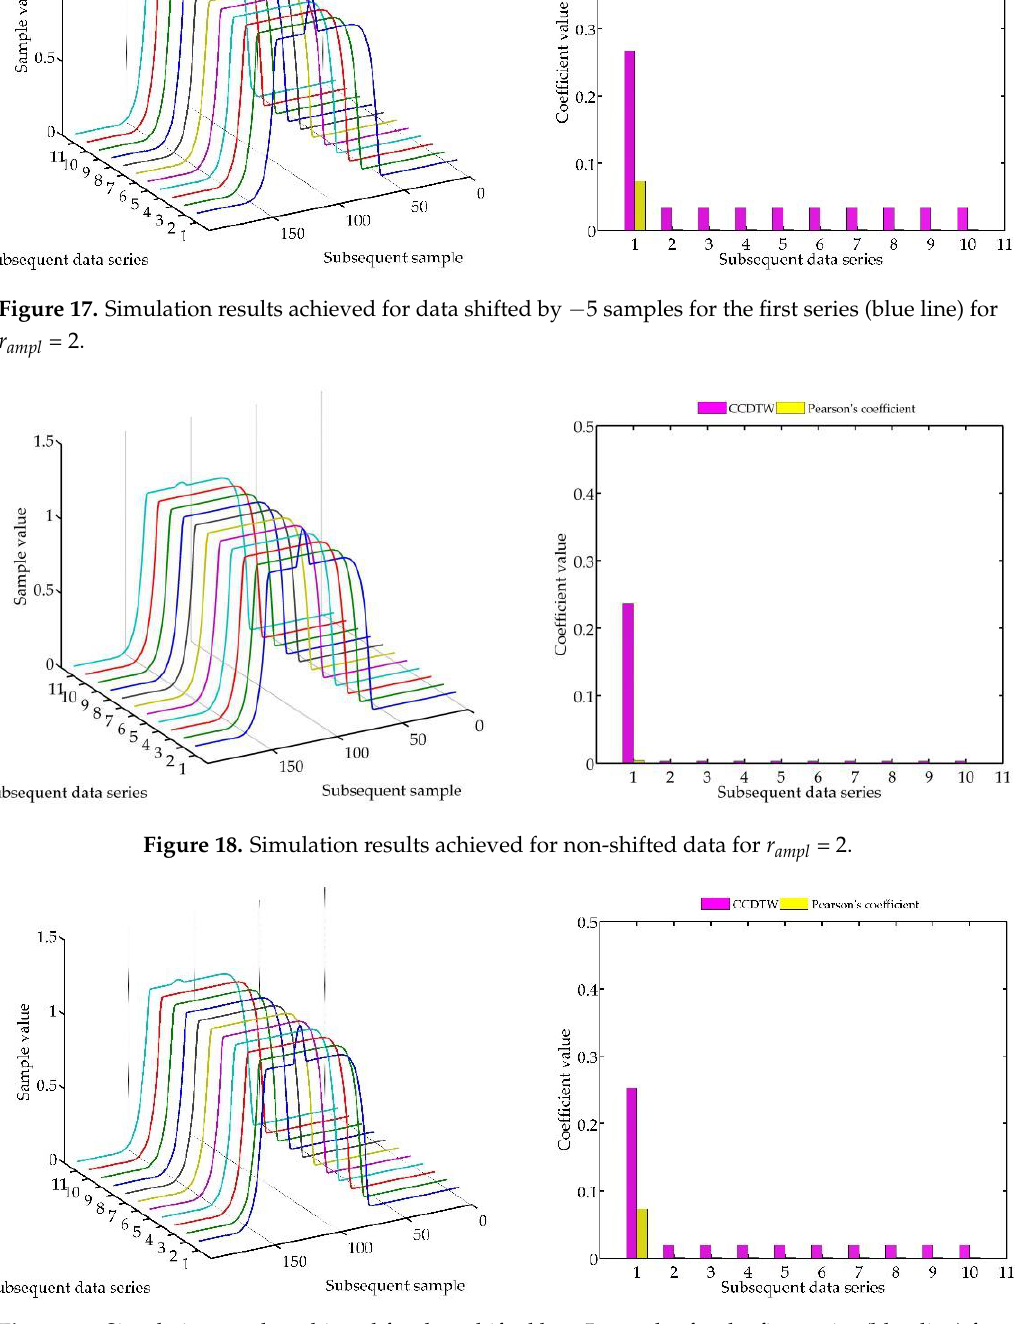
Figure 19. Simulation results achieved for data shifted by +5 samples for the first series (blue line) for r ampl = 2.